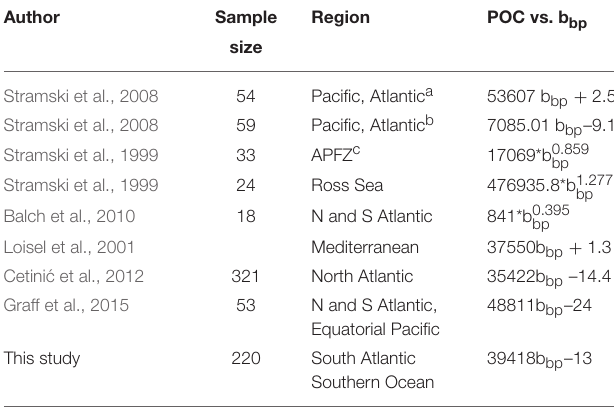
TABLE 2 | Comparison of POC vs. b bp reported from literature for original wavelength [taken from Cetini´c et al. (2012)] with the addition of results from Graff et al. (2015) and this